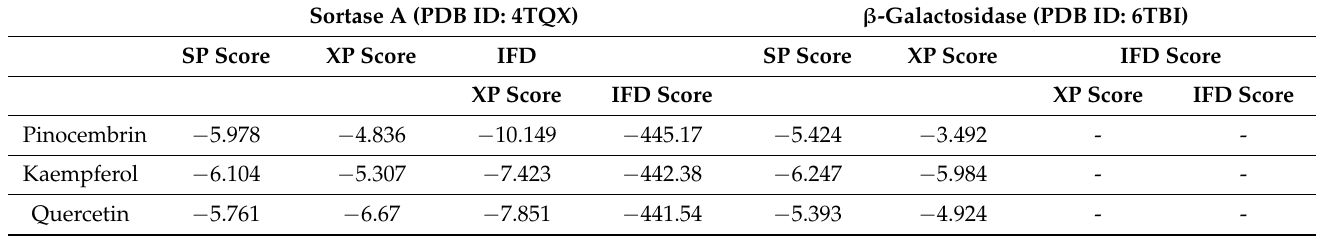
Table 4. Identification of key binding poses of the Sortase A and β -galactosidase active sites involved in binding with propolis. Sequences established as per number of residues. Synthetic and protein ligands were removed, as well as crystallographic water molecules.